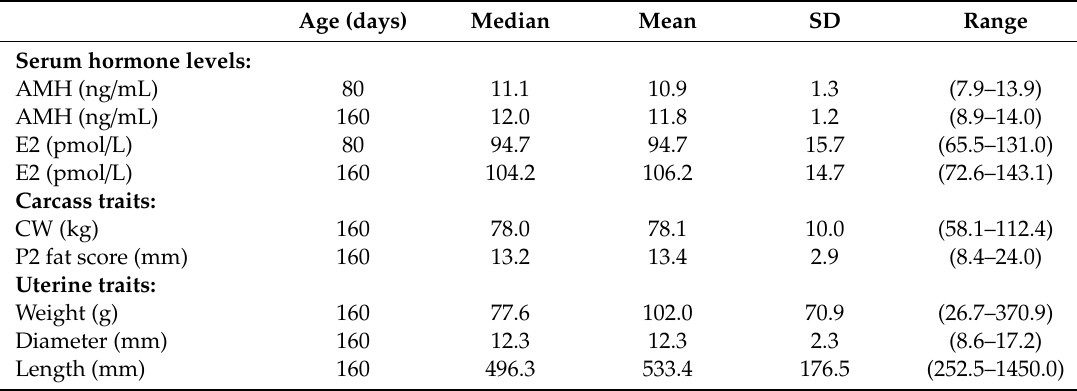
Table 1. Descriptive statistics for serum concentrations of AMH and E2 in gilts at 80 and 160 days of age, and carcass, uterine and ovarian properties at 160 days of